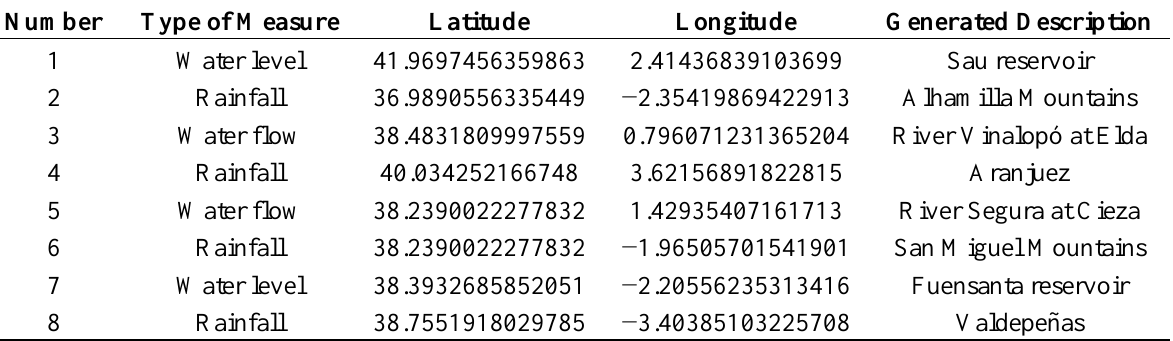
Table 2. Examples of generated